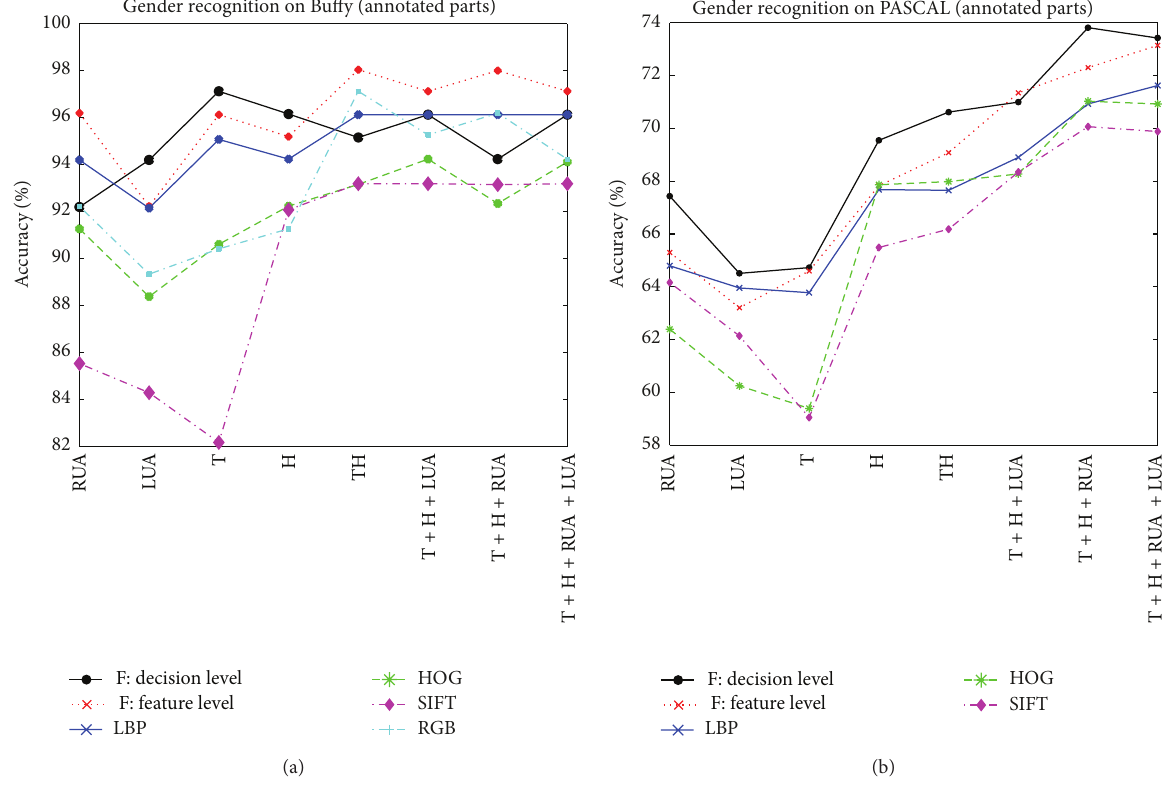
Figure 7: Gender recognition results with annotated parts on Buffy (a) and PASCAL (b).